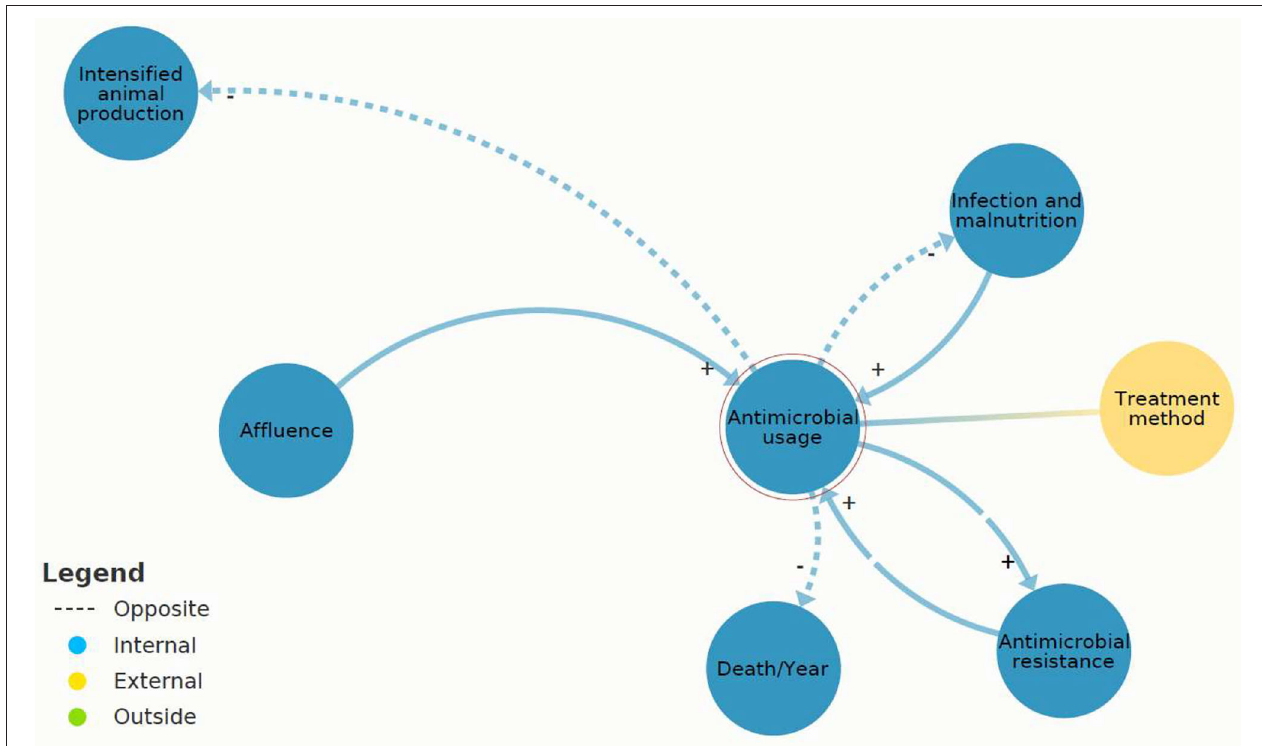
FIGURE 4 | A section of Figure 3 : causal loops in present antimicrobial resistance (AMR) system map between “antimicrobial usage” (AMU) and “AMR” created in Kumu.io ( 27). would reinforce malnutrition (“infection and